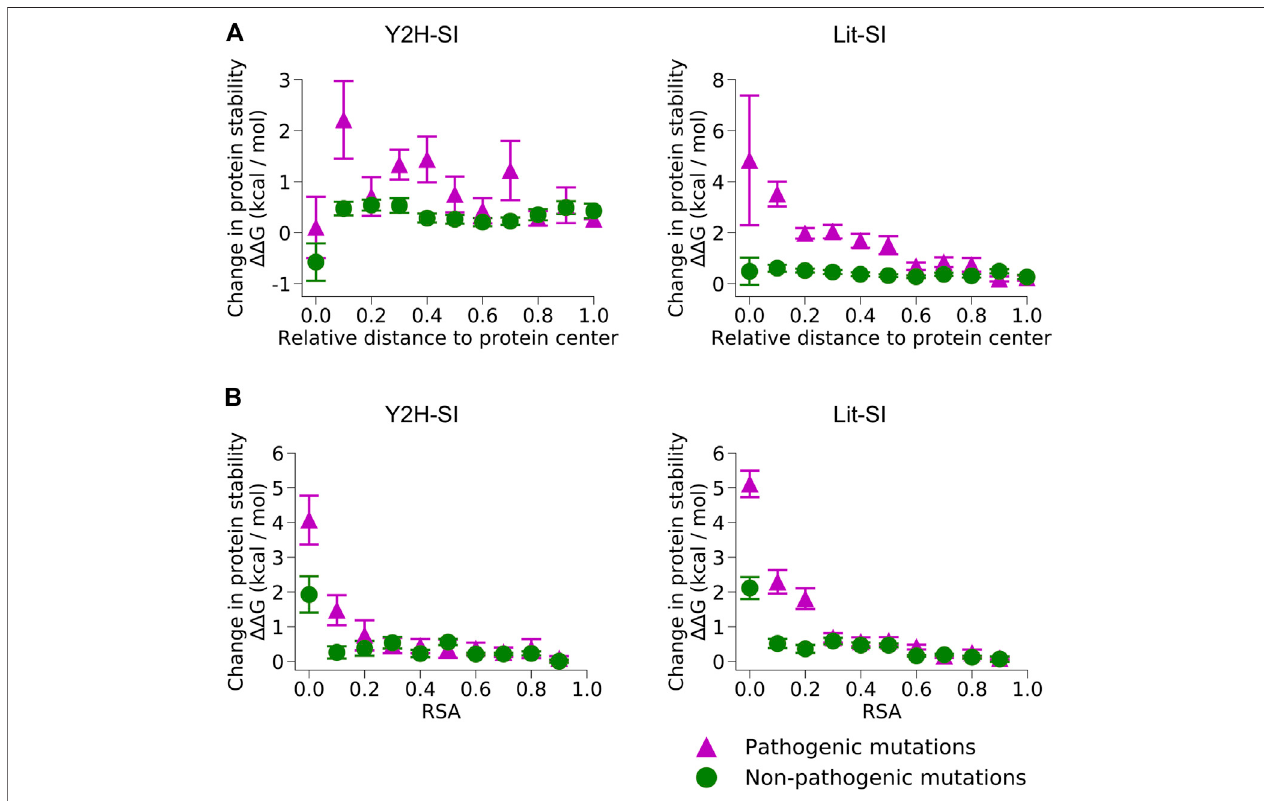
FIGURE3| Changeinproteinstabilityuponmutation.Changeinproteinfoldingfreeenergy( ΔΔ G)createdbypathogenicmutationsandnon-pathogenicmutations in the two human structural interactomes, Y2H-SI (left) and Lit-SI (right) , in relation to (A) mutation distance to protein center relative to protein radius and (B) relative solvent accessibility (RSA) of the mutation